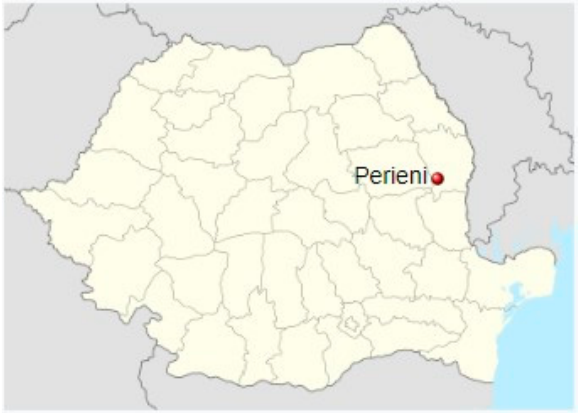
Figure 1. The location of Perieni locality. Source: [4,5].